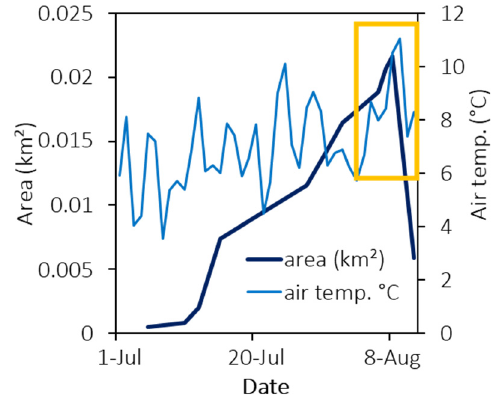
Figure 3. Lake area and summer daily average air temperatures in 2019 (Tien Shan meteorological station (MS)).